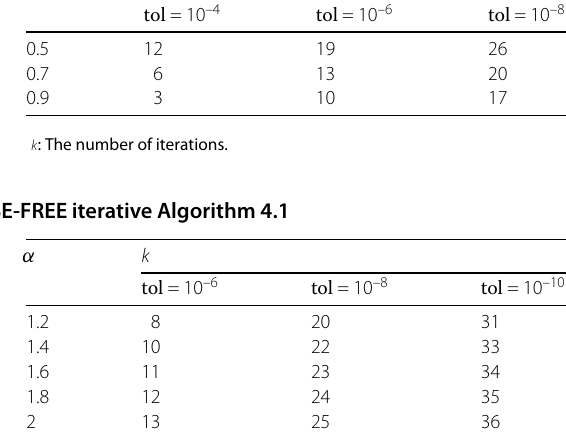
Table 2 INVERSE-FREE iterative Algorithm 4.3 α k tol = 10 –4 tol = 10 –6 tol = 10 –8 0.5